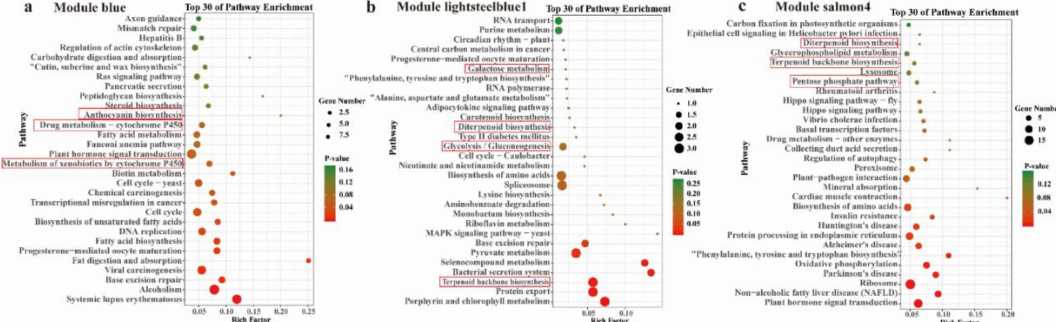
Figure 11. Kyoto Encyclopedia of Genes and Genomes (KEGG) pathway enrichment of interested module. ( a ) Module blue; ( b ) module lightsteelblue1; ( c ) module